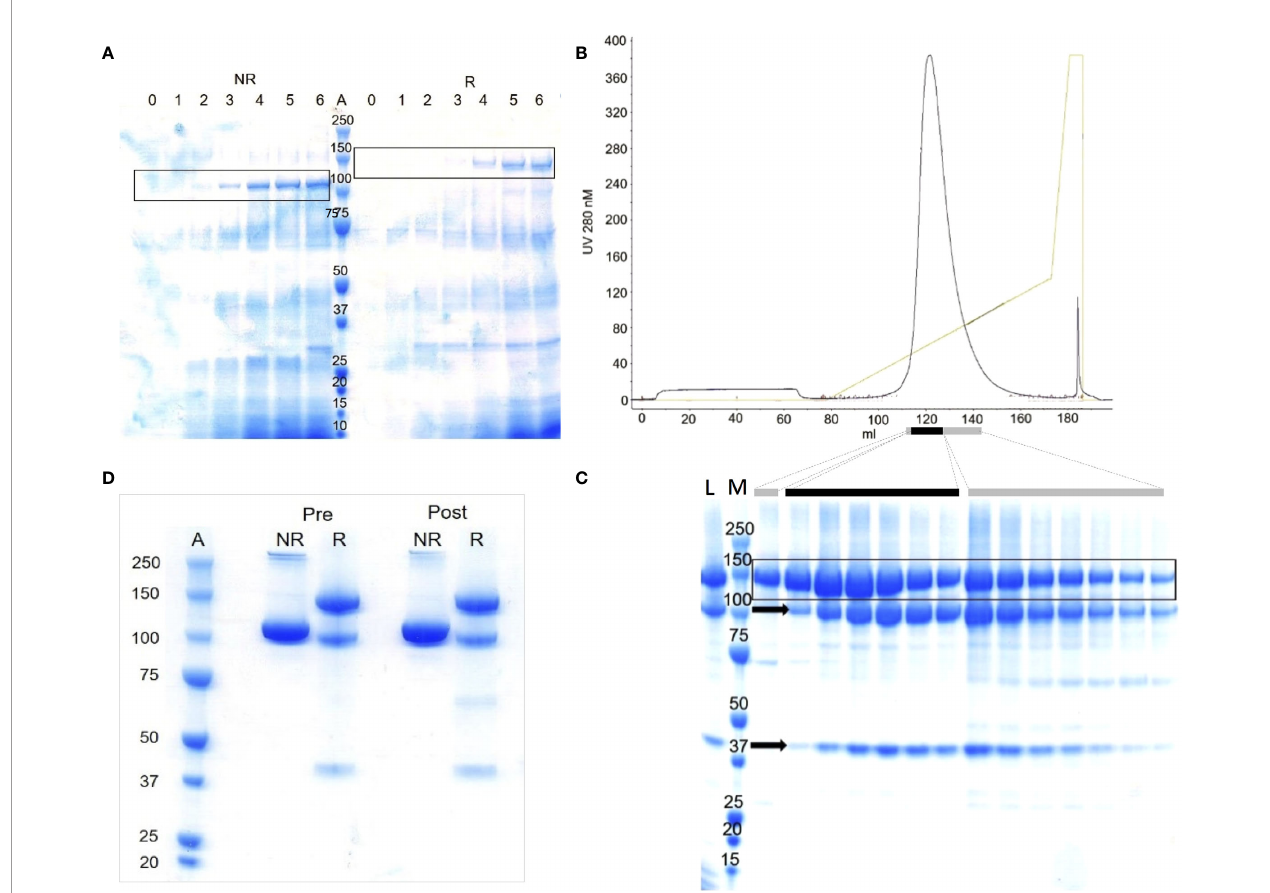
FIGURE 1 | Production of recombinant mFH by fermentation of KM71-PDI-CFH. (A) Lanes 0-5, deglycosylated samples (10 µL) from fermentation days (d) 0-5: induced with methanol, d1; fed with methanol, d2-4; harvested, d5. Lane 6, as lane 5 with PMSF added post-harvest. Lane A, MWt markers (MWM) (kDa). NR/R; run under non-reducing/reducing conditions. (B) Puri fi cation on Source Q of one third of the material harvested and initially captured on cation-exchange resin; elution pro fi le (0-1 M NaCl over 12 column volumes). (C) Lane L, loading sample (10 µL); Lane M, MWM; other lanes, aliquots of 2 µL (black bar) or 10 µL (grey bars) from main-peak fractions; Arrow, “ clipped ” protein fragments. In frames (A, C) , candidate rmFH bands are boxed. (D) Samples of recombinant mFH used in vivo ; 5 µL loaded per well. “ Pre ” , before LPS removal. “ Post ” , after LPS removal. Lane A,